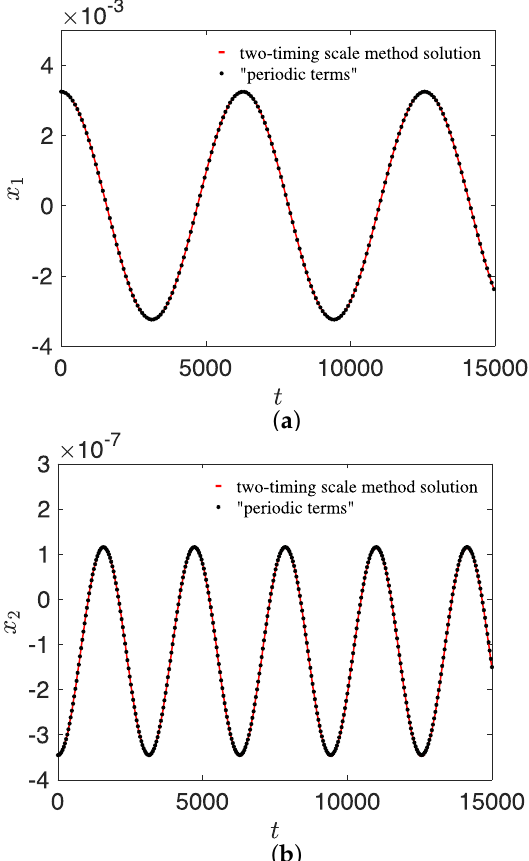
Figure 3. A comparison between the asymptotic solution and asymptotic periodic solution for A = 0.3703, s = 0.04, µ 0 = 0.1, ω = 0.01, δ = 0.004 and (cid:101) = 0.001: ( a ) Time-history diagram in x 1 -direction, ( b ) Time-history diagram in x 2